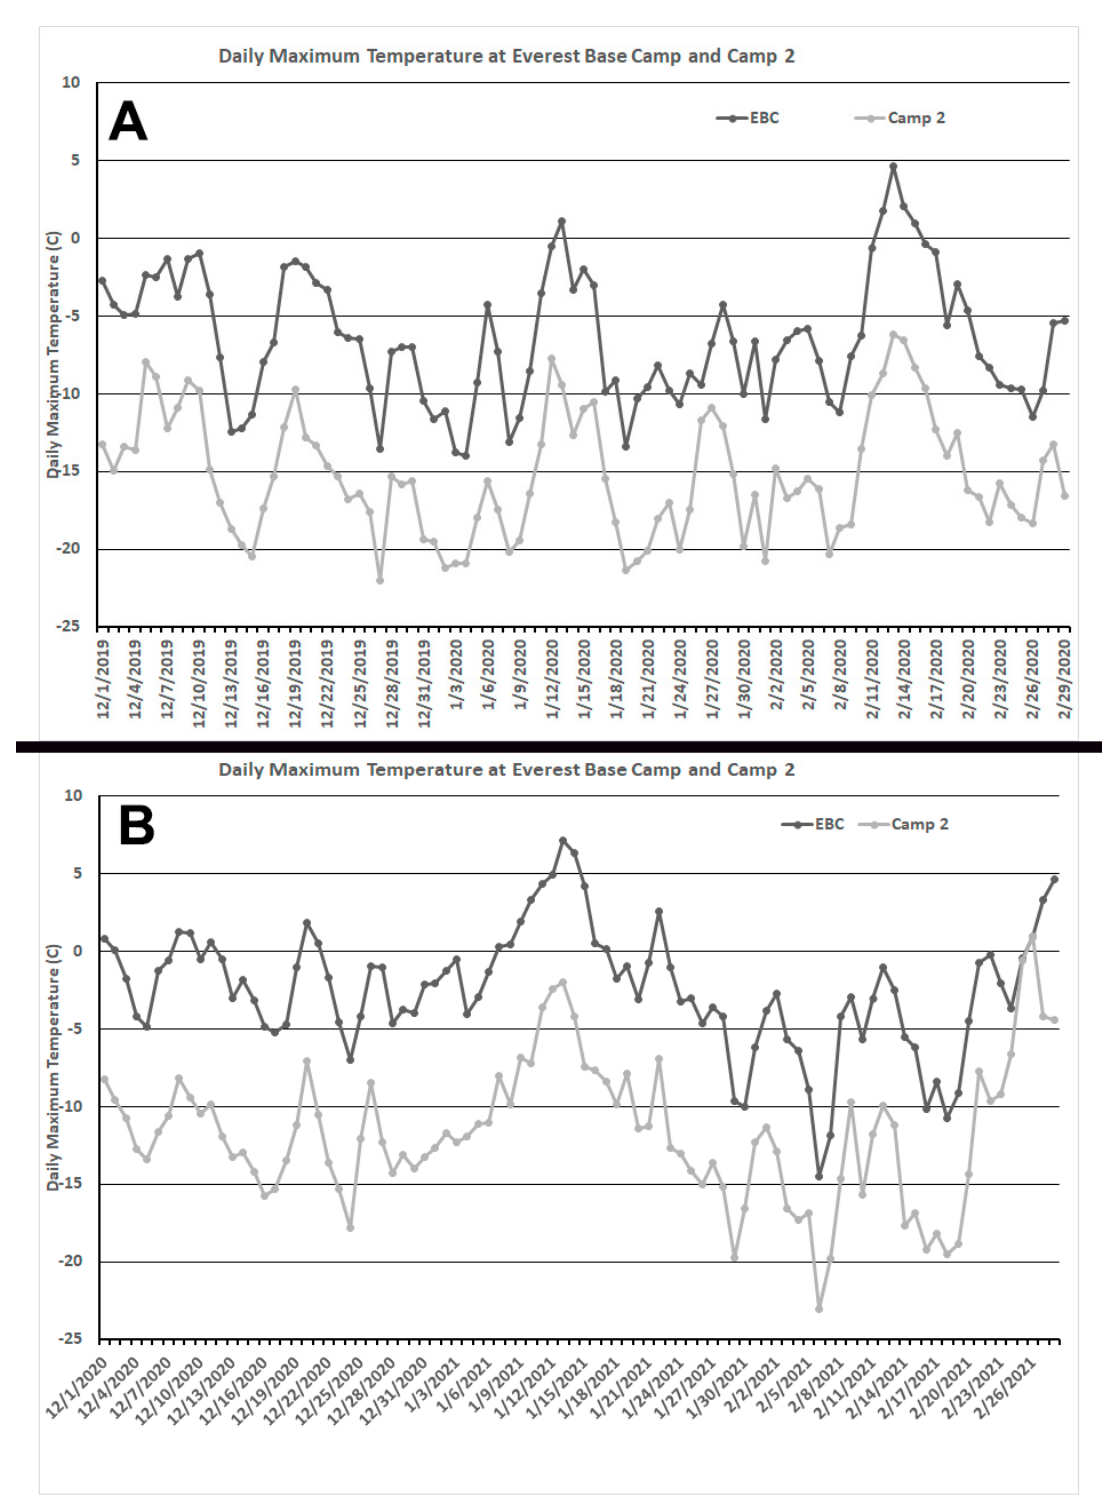
Figure 7. Daily maximum temperature at Everest Base Camp and Camp 2 for the winter seasons of ( A ) 2019/2020 and ( B ) 2020/2021.